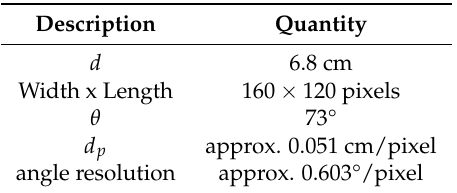
Figure 7. Scheme presenting the camera distance from the surface and the image formation at the CMOS sensor. Table 3. Image variables and pixel size equivalency.